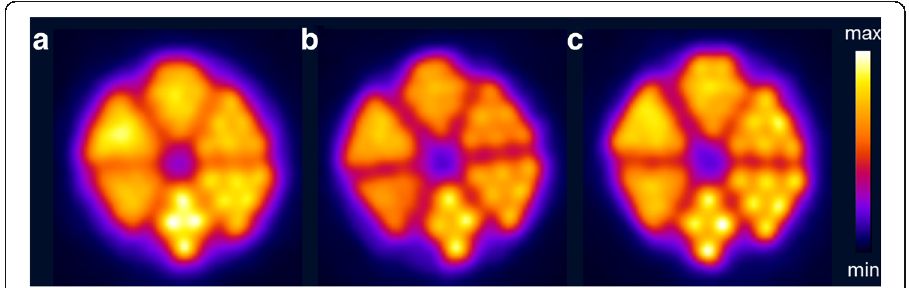
Fig. 4 Transversal slices of PET scans of Derenzo phantoms (hole diameter ranging from 0.8 – 1.3 mm in 0.1 mm steps) filled with >99% 44 Sc ( a ), 66.2% 43 Sc ( b ) and 98.2% 43 Sc ( c ). The acquisition of the PET scans was performed in an energy window of 400 – 700 keV for 30 min, in order to obtain a total number of ~6 × 10 7